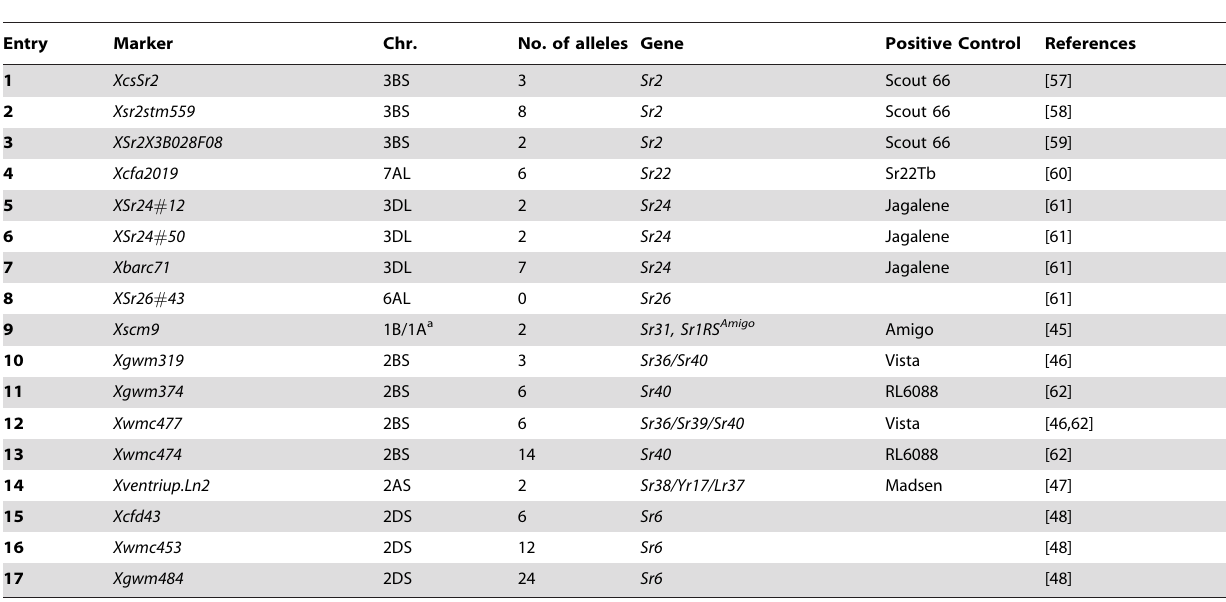
Table 1. List of markers associated with rust resistance genes, assigned chromosome, and number of alleles detected for each marker across 137 U.S. wheat accessions.